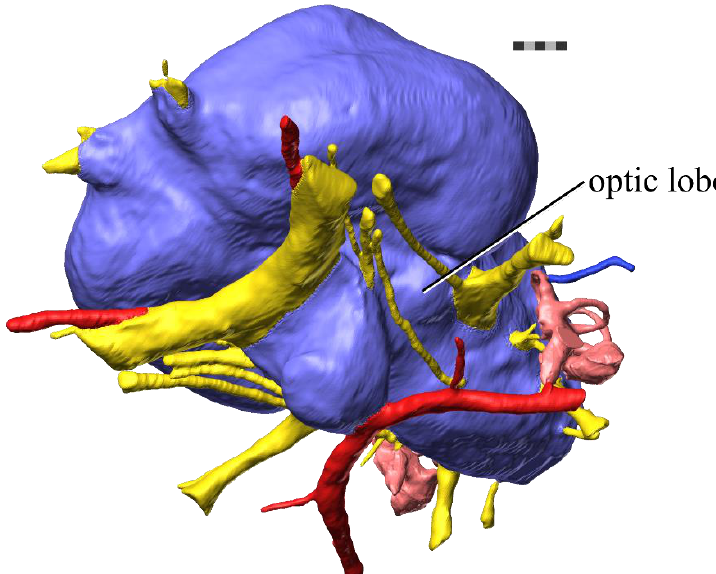
Figure 7. The endocast of Dinornis robustus in a left ventral oblique view to highlight the size and position of the optic lobe relative to other brain structures. The brain endocast is modeled in light blue, cranial nerves are modeled in yellow, arteries are modeled in red, veins are modeled in dark blue, and semicircular canals are modeled in pink. Scale bar = 5 mm.